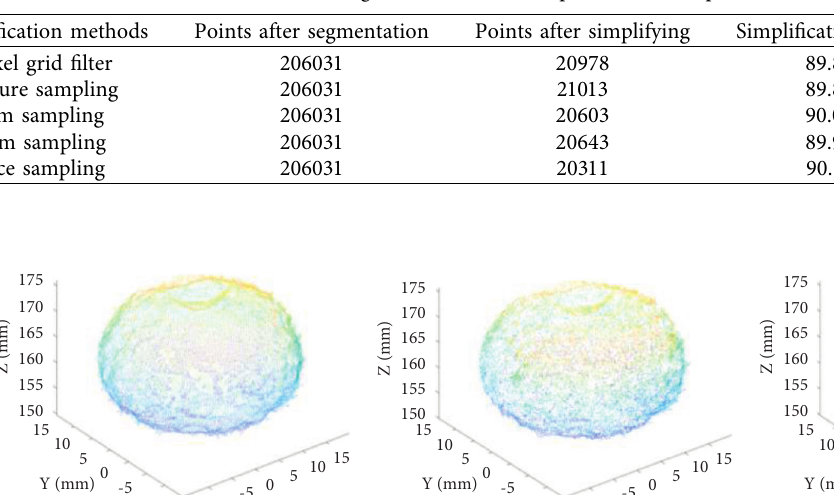
Table 1: Average errors of different point cloud simplification methods.